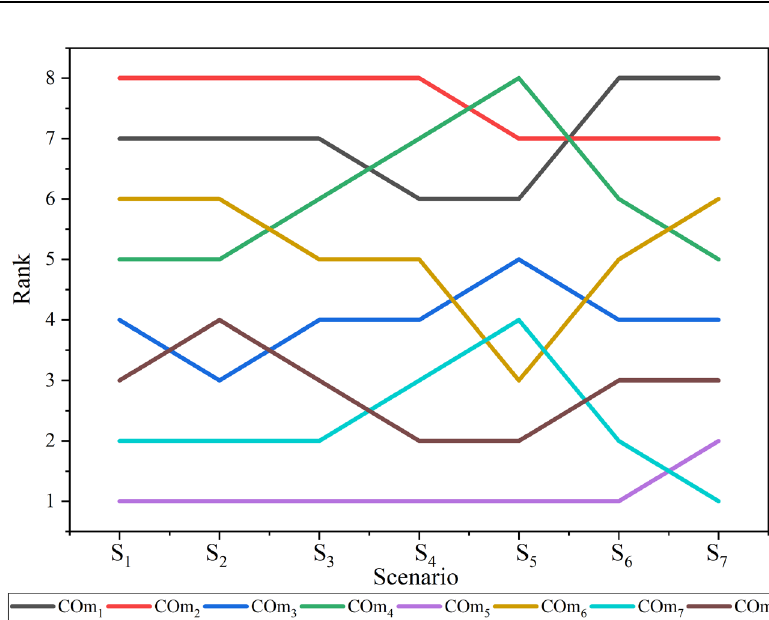
Figure 2. Ranking of alternatives for seven different scenarios.